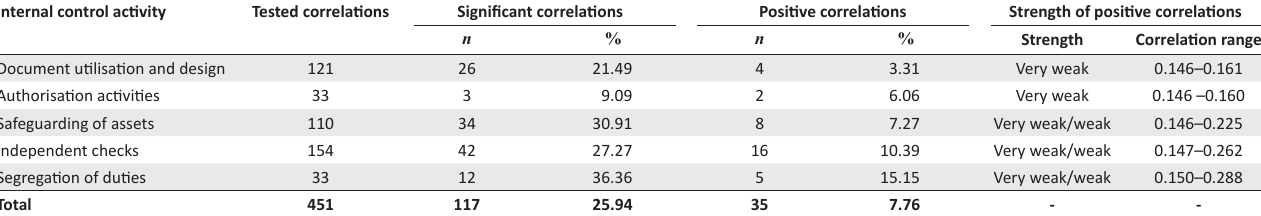
TABLE 1: Summary of significant correlations between the managerial conduct and internal control